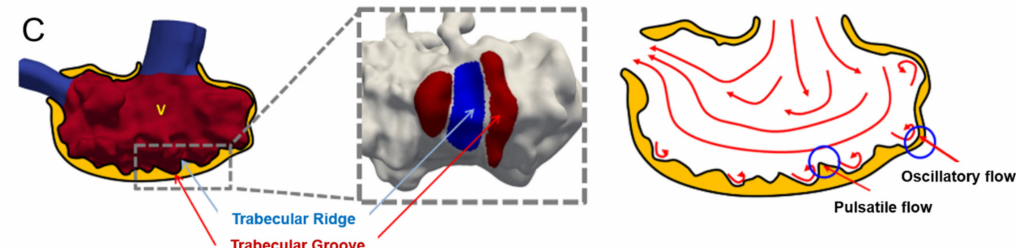
Figure 4. Blood flow in the embryonic zebrafish heart. ( A ) Velocity streamlines for three normal ventricles over the cardiac cycle. During the diastole, laminar flow with high velocity is observed at the ventricular inlet (Reproduced from Yin et al. (2020) [132]). ( B ) Instantaneous flow streamlines at atrial contraction and relaxation for different embryonic development stages ranging from 20 to 120 hpf. The atrioventricular (AV) canal is shown in the circle. At later stages of development, rotating vortices are observed in the ventricle during atrial contraction, and in the atrium during ventricular contraction. A: Atrium, V: Ventricle (Reproduced from Lee et al. (2013) [133]). ( C ) Ventricular trabeculation is observed at later stages (after 3 dpf) of development, resulting in pulsatile flow at ridges and oscillatory flow at grooves (Reproduced from Lee et al. (2018)